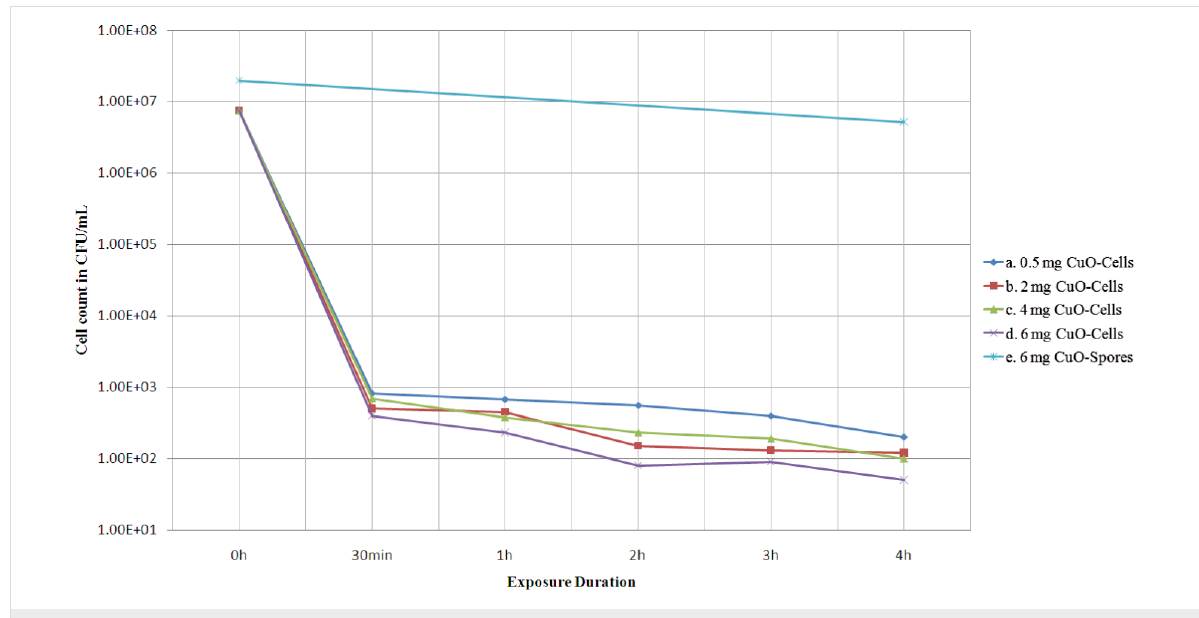
Figure 6: Antibacterial activity of multi-armed copper oxide NPs (P5) against B. anthracis vegetative cells and B. anthracis spores at various time intervals. The control set has shown a variation below 20% during the test period (4 h).